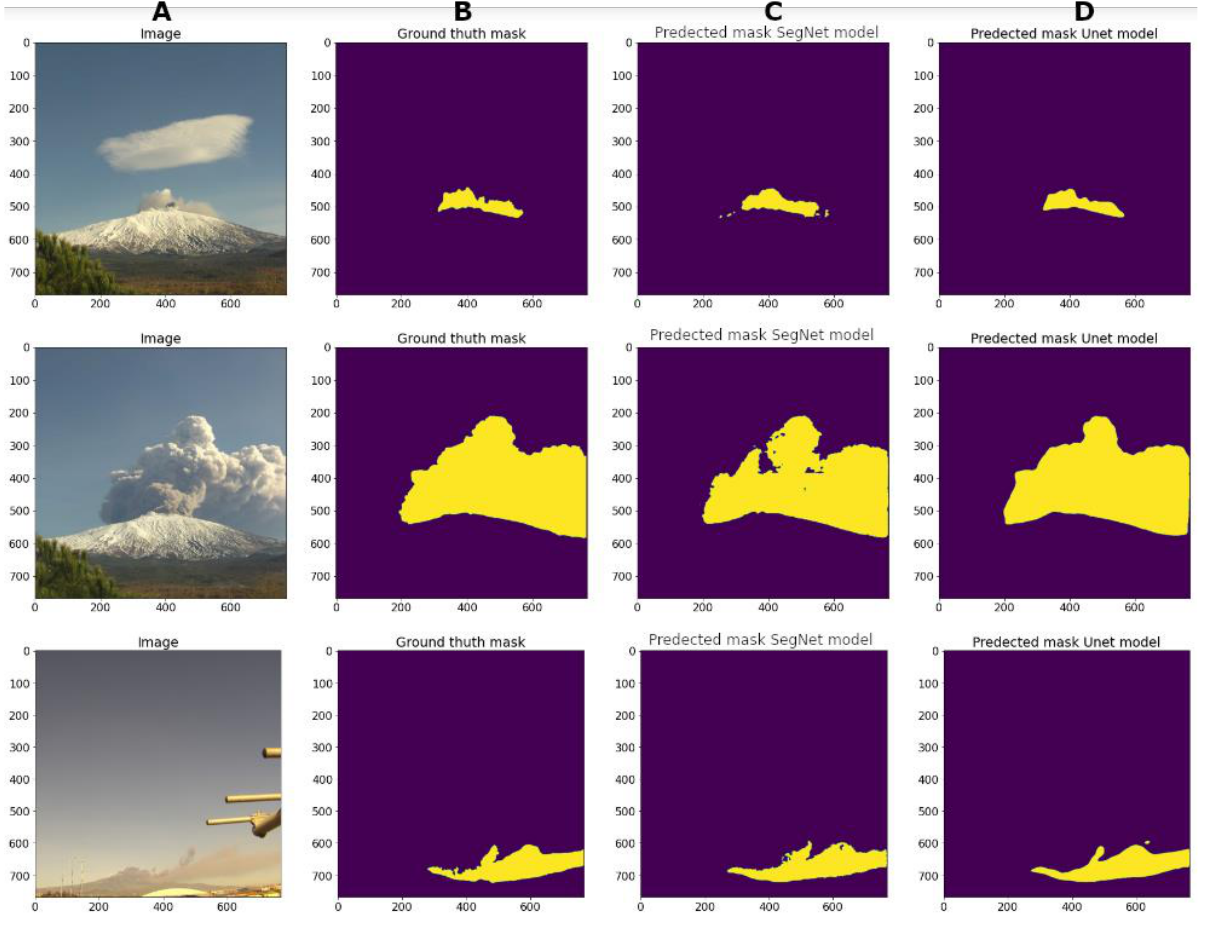
Figure 13. Original image ( A ), ground truth mask ( B ), predicted mask by SegNet ( C ), predicted mask by U-net ( D ).